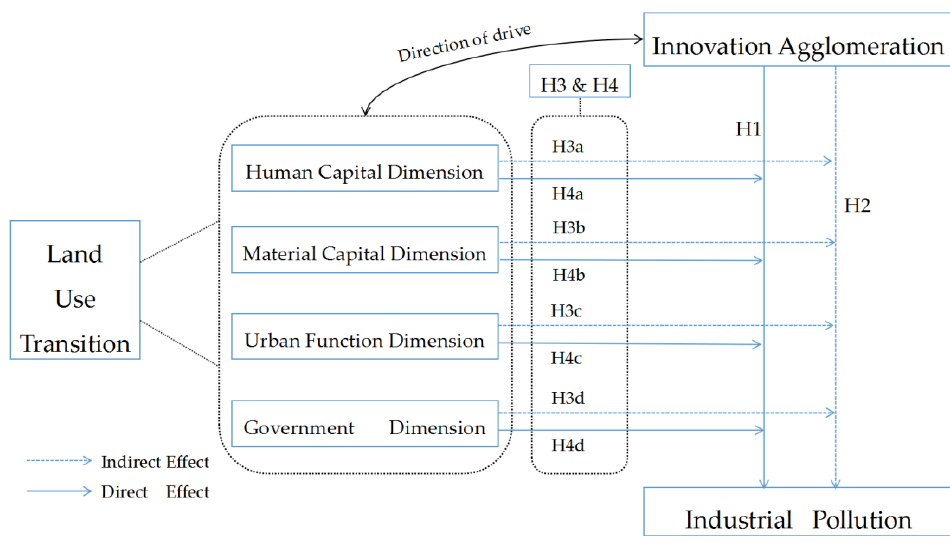
Figure 1. Mechanistic